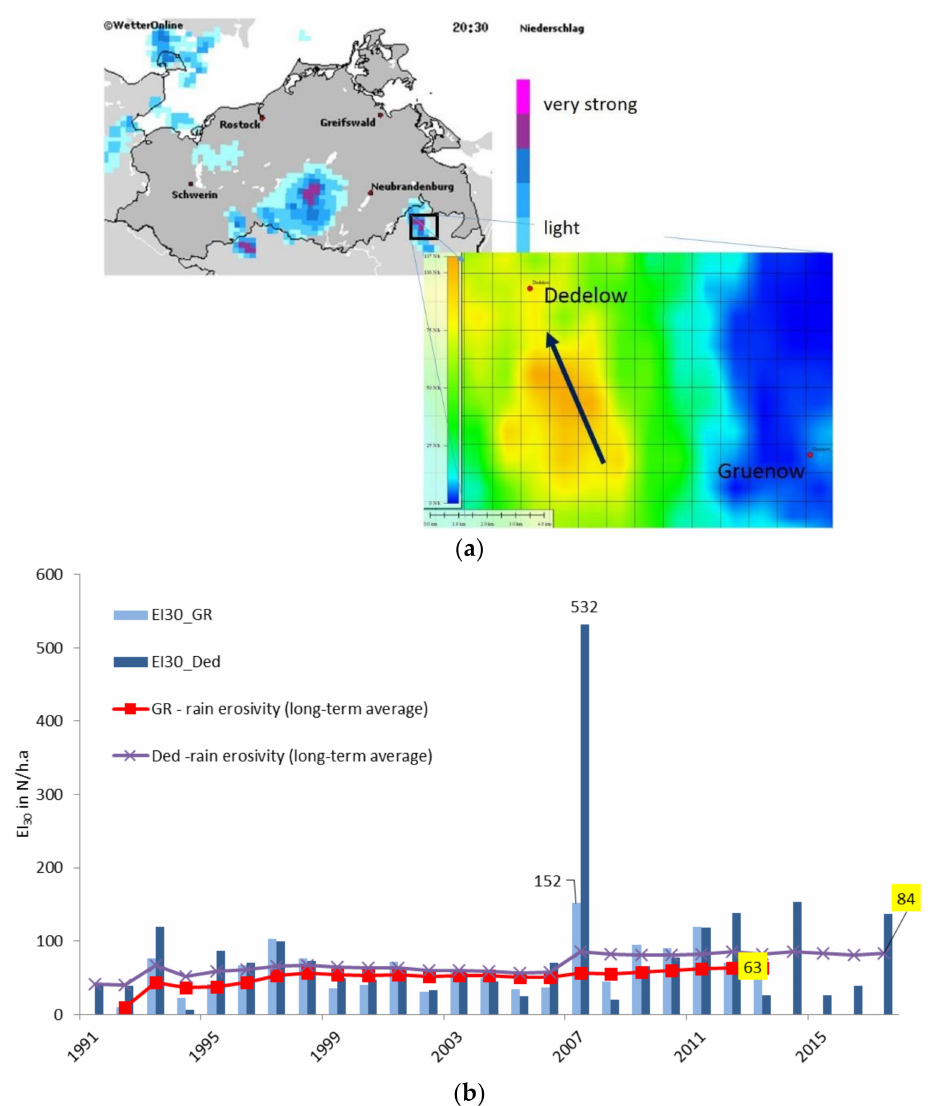
Figure 15. The thunderstorm on 5 June 2007 in North-East (NE) Germany and its e ff ect on the rainfall erosivity. ( a ) The arrow indicates its route. The rainfall intensity increases from blue to purple (above) and from blue to orange (inset map), data sources: WetterOnline and rain radar data of the DWD, ( b ) annual rainfall erosivity for the stations Dedelow (Ded, dark blue) and Grünow (GR, light blue), about 95 km north of Müncheberg in NE Germany (long-term mean values in yellow), data source: 10min-data ZALF for Dedelow; DWD for